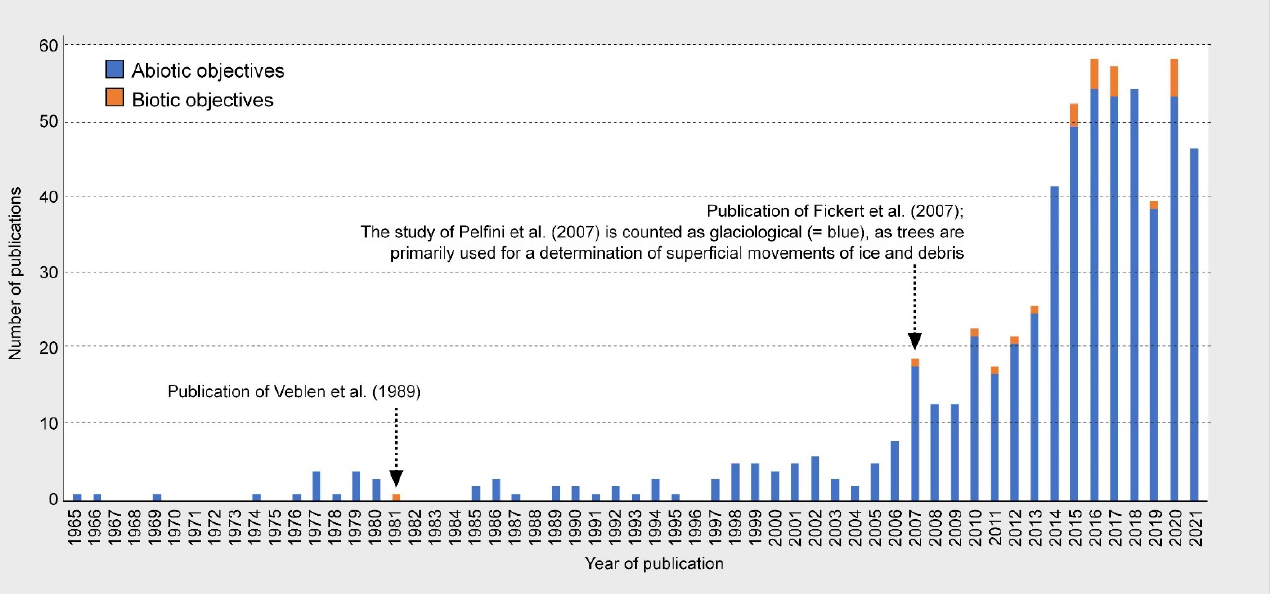
Figure 2. Bibliometric search (as of 10/2021) in the “Dimensions” Database for English language publications including the keyword “debris-covered glacier” in title or abstract. Matches were screened for objective and classified into publications with a primarily abiotic (i.e., glaciological, hydrological, geomorphological, climatological and mapping issues) and with a primarily biotic focus (i.e., flora, fauna, microbes and interactions). Papers dealing exclusively with rock glaciers, with a paleo perspective (i.e., Pleistocene, early Holocene) or with related features on Mars are excluded.